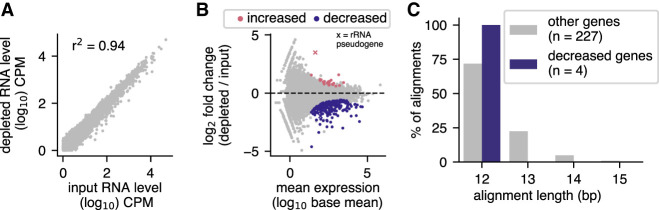
Ribo-Pop has minimal effects on expression measurements of non-rRNA genes. RNA-seq libraries prepared after Ribo-Pop depletion were compared to libraries made from nondepleted input RNA. To allow sufficient coverage for analysis, libraries were prepared using a poly(A)-primed method (QuantSeq). (A) Scatterplot and the Pearson's correlation between input and depleted RNA levels for mRNAs and ncRNAs. The RNA levels are the averages of three replicates for each condition, filtered to include only genes with an average of at least 1 count per million (CPM). Each replicate was prepared from a different RNA sample and corresponds to the same material used for the non-poly(A)-primed libraries analyzed in Figure 4. (B) MA plot for the comparison of Ribo-Pop depleted versus input libraries analyzed with DESeq2 (Love et al. 2014). Genes with an adjusted P-value <0.01 for differential expression are highlighted in pink if increased upon depletion or blue if decreased upon depletion. The two rRNA pseduogenes that are among the changing genes are indicated. (C) Stretches of complementarity between the Ribo-Pop probes and nontarget RNAs were identified by aligning the probe target sites to the transcriptome with BLAST (Altschul et al. 1990). Alignments are classified as overlapping a gene decreased upon Ribo-Pop depletion (decreased) or overlapping a gene not decreased upon depletion (other). Only alignments with 100% identity are displayed.